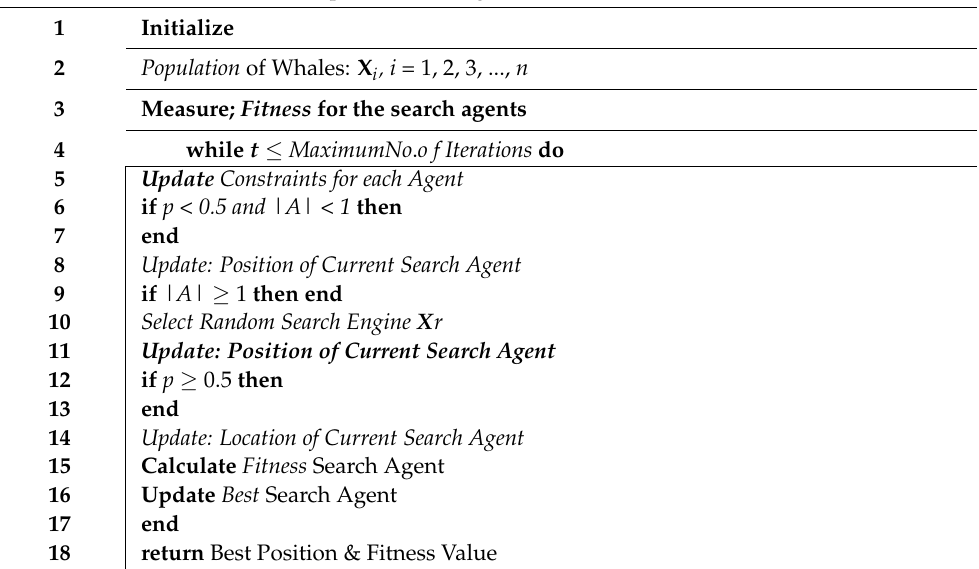
Algorithm 1: Modified Whale Optimization